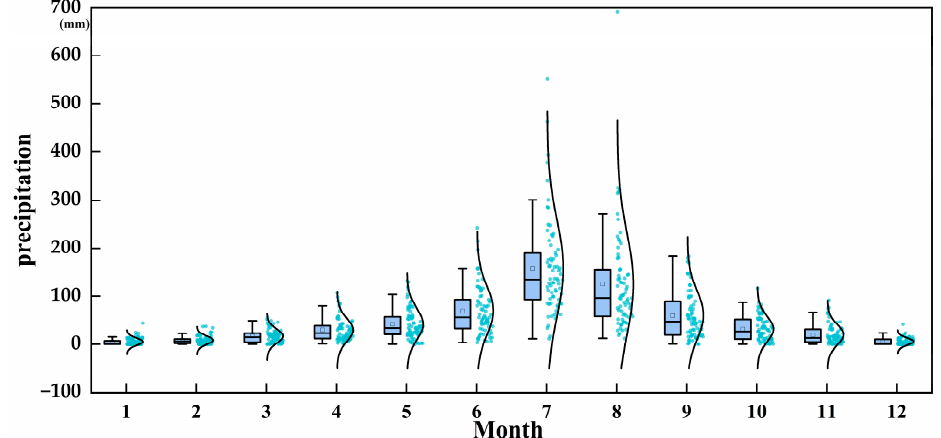
Figure 5. Boxplot of monthly precipitation at Zhengzhou Station during 1951–2020.